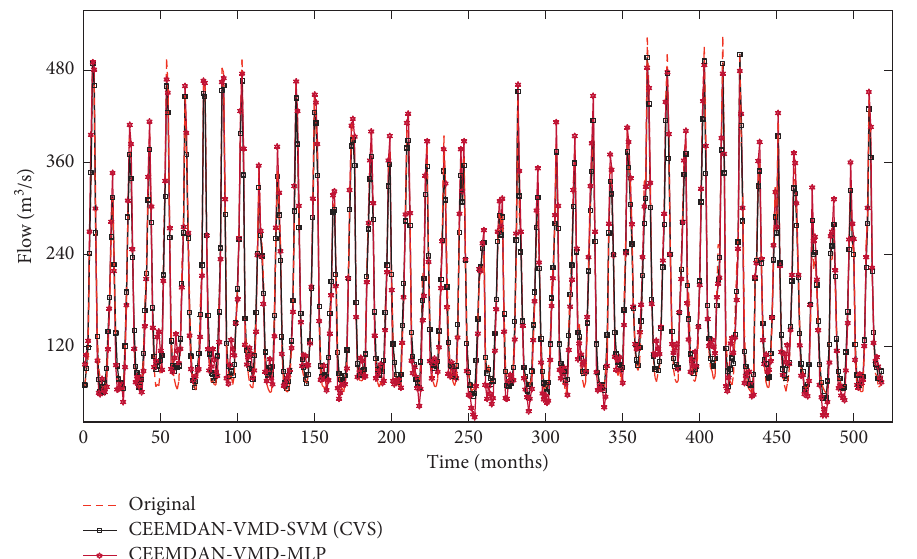
Figure 8: Observed and predicted runoff during the model training period using CVS and CEEMDAN-VMD-MLP